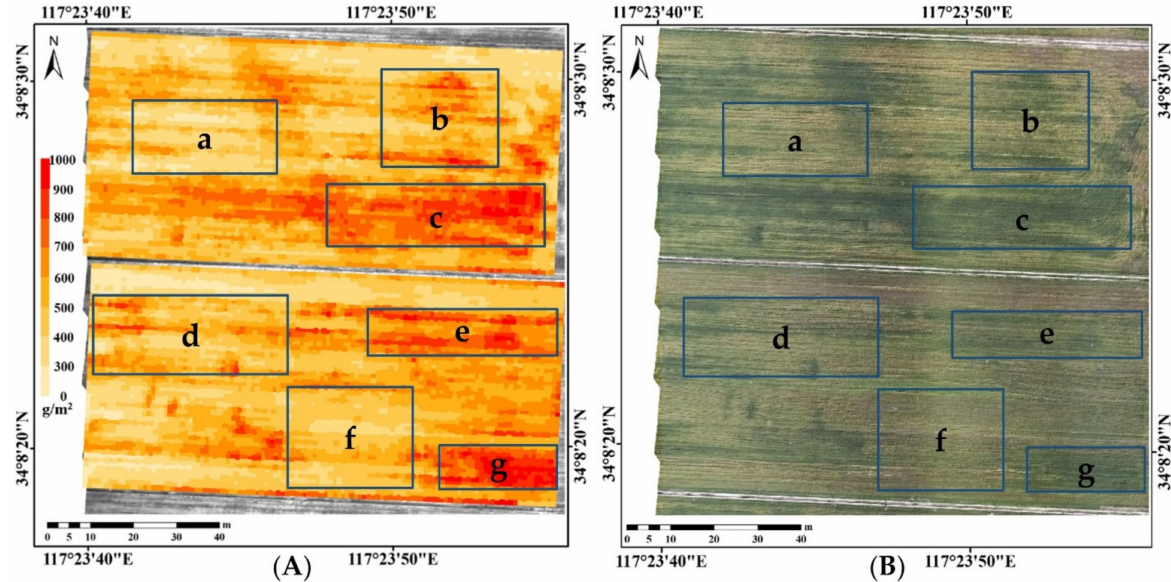
Figure 10. ( A ) Spatial distribution of winter wheat yield predicted from the GPR model constructed by the ESCVIs at the flowering and filling stages in the area studied. ( B ) Mosaic result of UAV RGB image in the area studied at the filling stage. a, b, c, d, e, f and g are the seven feature areas selected for comparisons of ( A , B